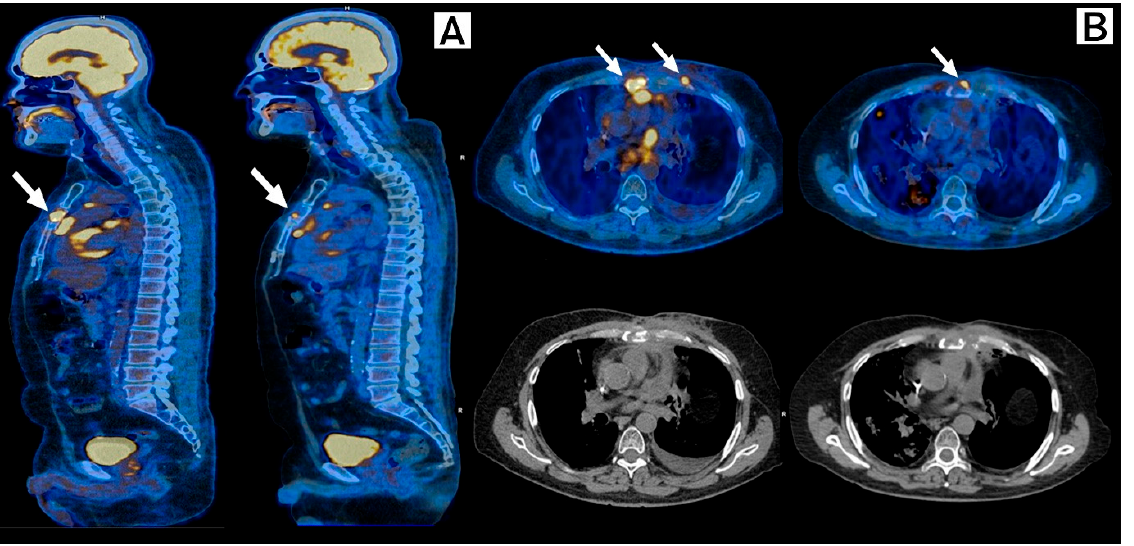
Figure 2. Response to Abemaciclib in the sternum and costochondral lesions. FDG-PET-Scan, Baseline ( left ) and 8 weeks after ( right ) after initiation of Abemaciclib. ( A ) Sagittal plane and ( B ) Transversal plane. Arrows show stable disease and complete metabolic resolution of costochondral lesions and near-complete metabolic response of the sternal lesion when compared with prior scans.